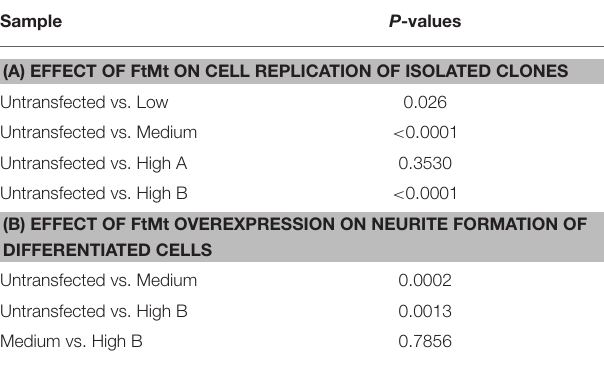
TABLE 2 | Effect of FtMt overexpression on Cell division and